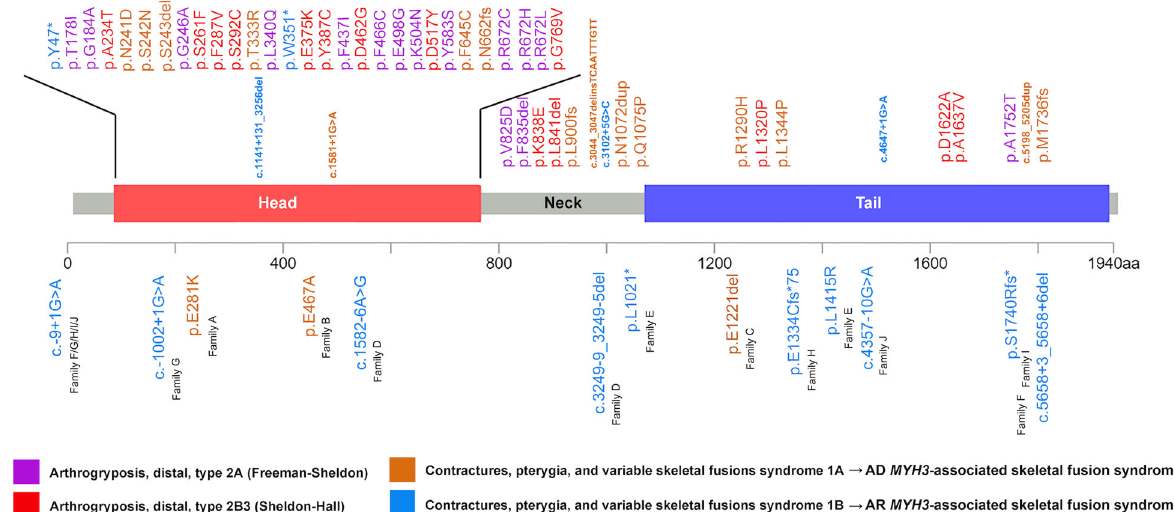
Fig. 3 Schematic representation of MYH3 variants in published literature (upper part of the fi gure) and in this study (lower part of the fi gure). Different colors annotate variants associated with different forms of MYH3 -associated